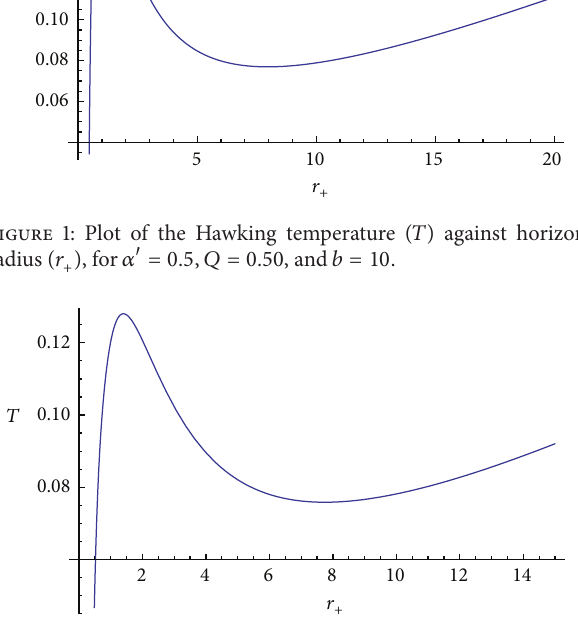
Figure 2: Plot of the Hawking temperature ( 𝑇 ) against horizon radius ( 𝑟 + ), for 𝛼 󸀠 = 1.0 , 𝑄 = 0.50 , and 𝑏 = 10 .